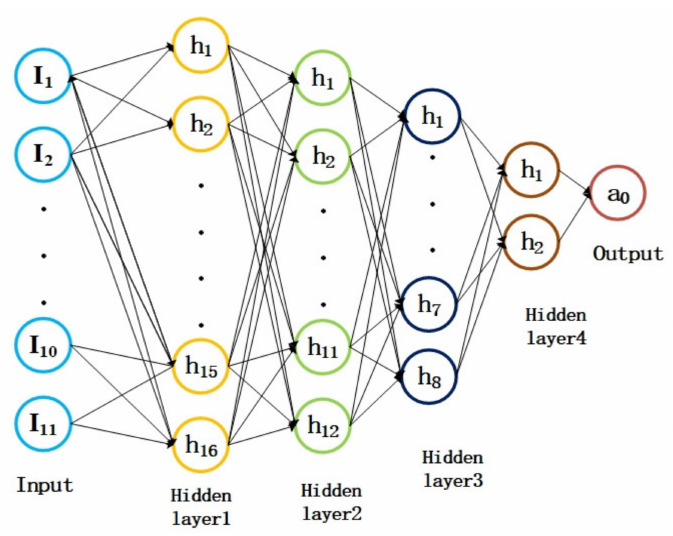
Figure 7. Overview of the machine learning model for impact ionization coefficient prediction.